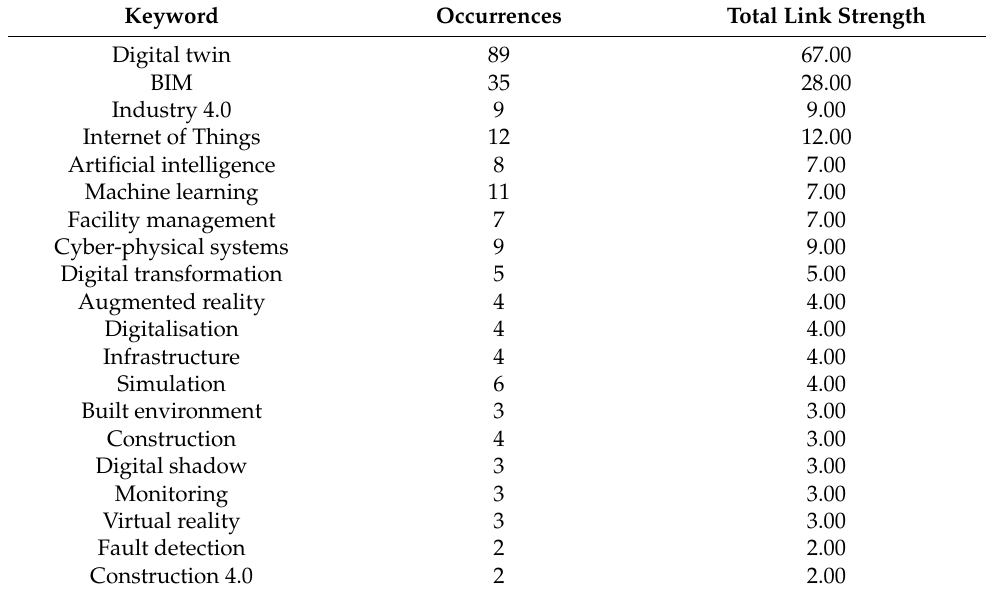
Table 4. Most active keywords in digital twin